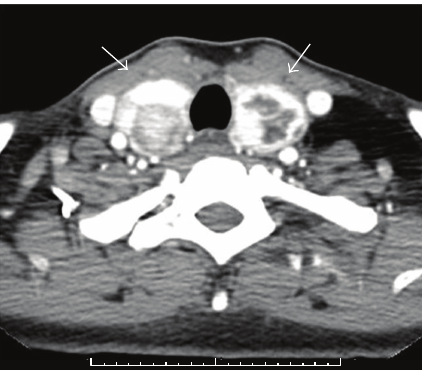
Figure 1: Axial postcontrast CT image through the thyroid gland demonstrates enlarged thyroid lobes that contain heterogeneously enhanc- ing nodules bilaterally.